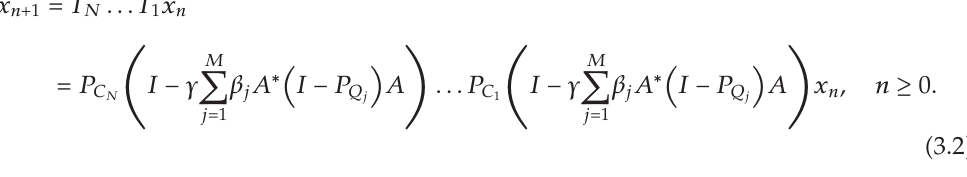
Algorithm 3.1. The Picard iterations